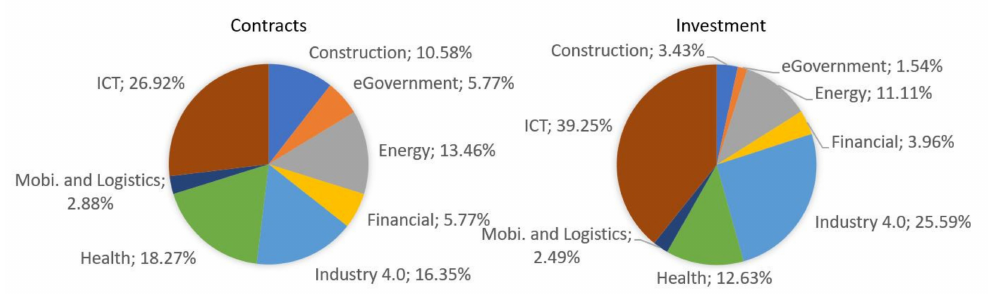
Figure 1. Blockchain investment distribution by sector.